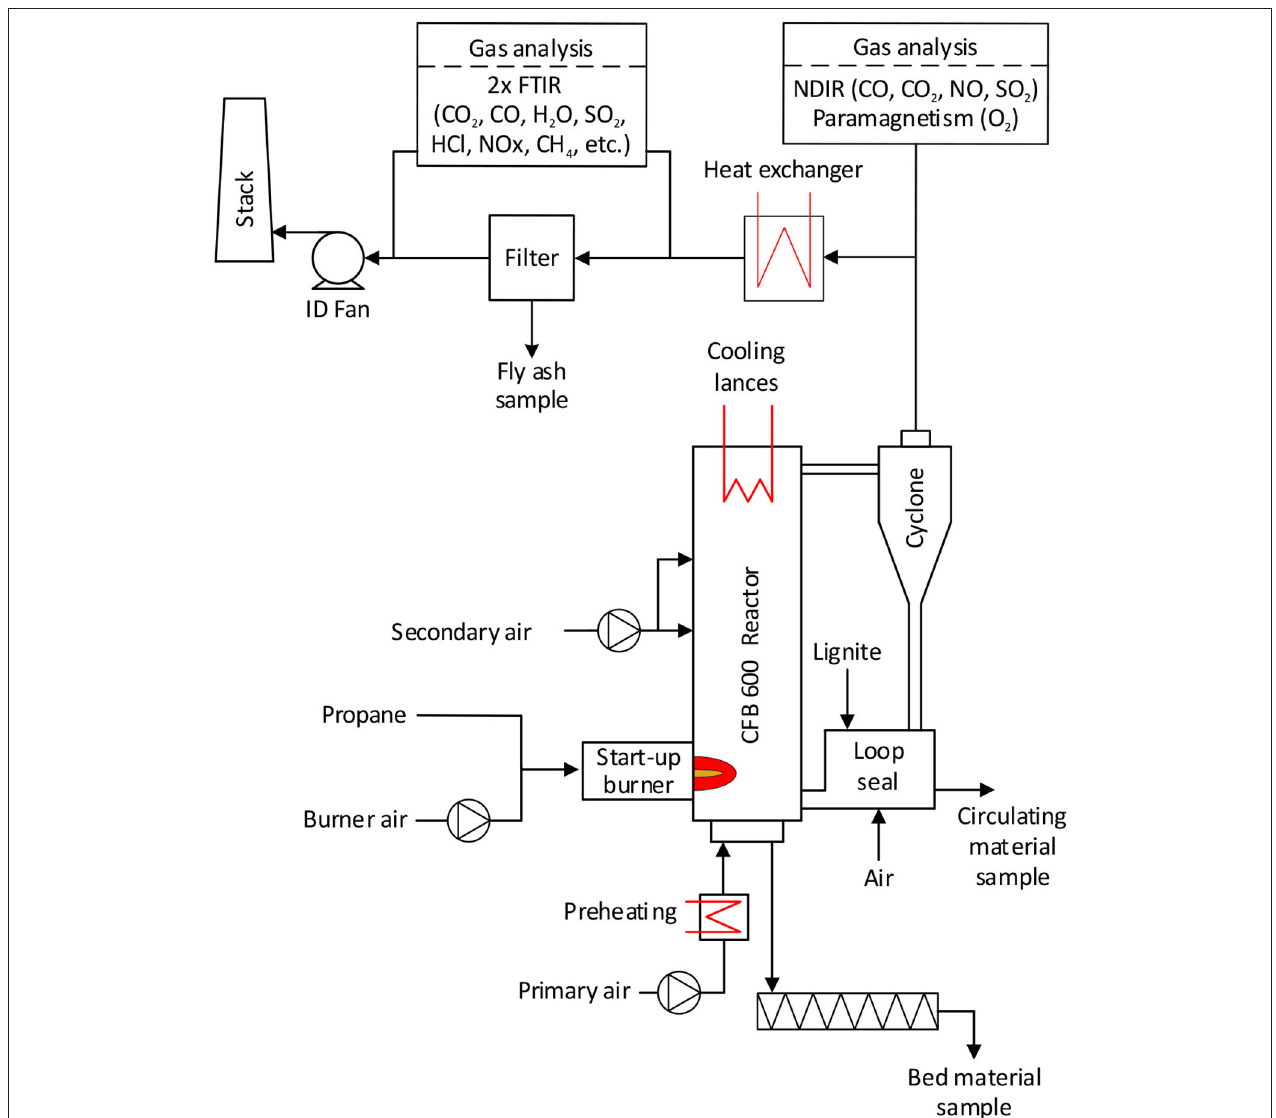
FIGURE 1 | Schematic of the CFB 600 pilot